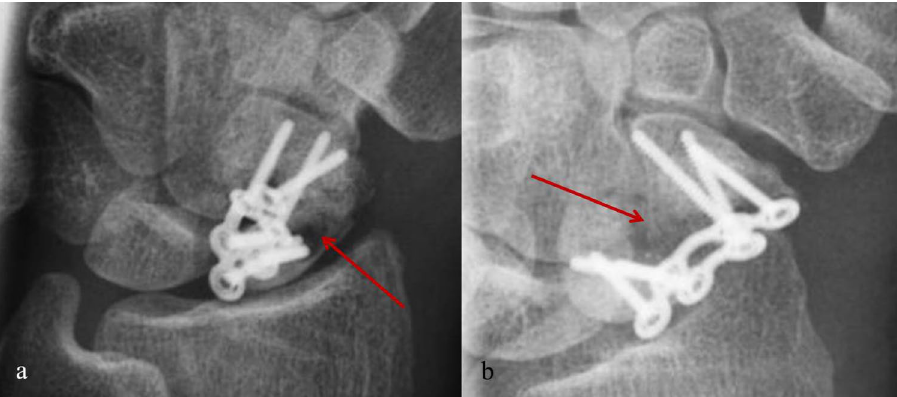
Figure 3. X-ray anteroposterior ( a ) and oblique ( b ). Pseudarthrosis in the Scaphoid (arrow) with retained anatomic